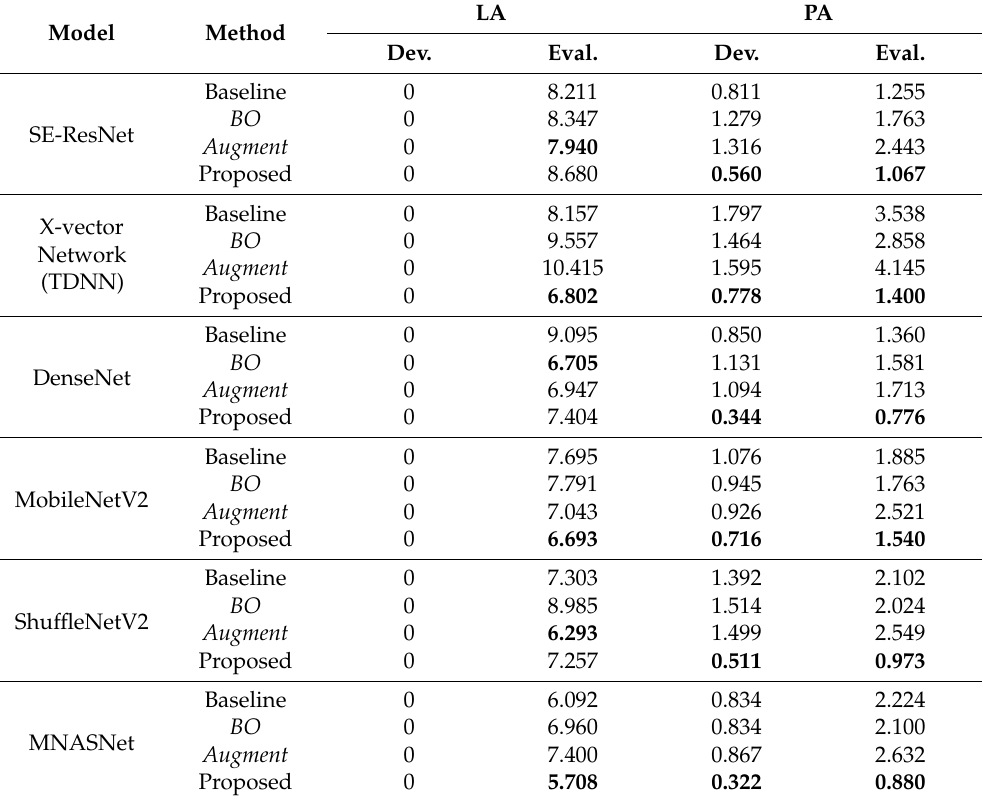
Table 3. Oracle EERs (%) of systems in the development and evaluation trials of ASVspoof 2019 LA and PA, with four different methods (i.e., baseline, BO , Augment , and proposed). For each model, the lowest EER is highlighted in